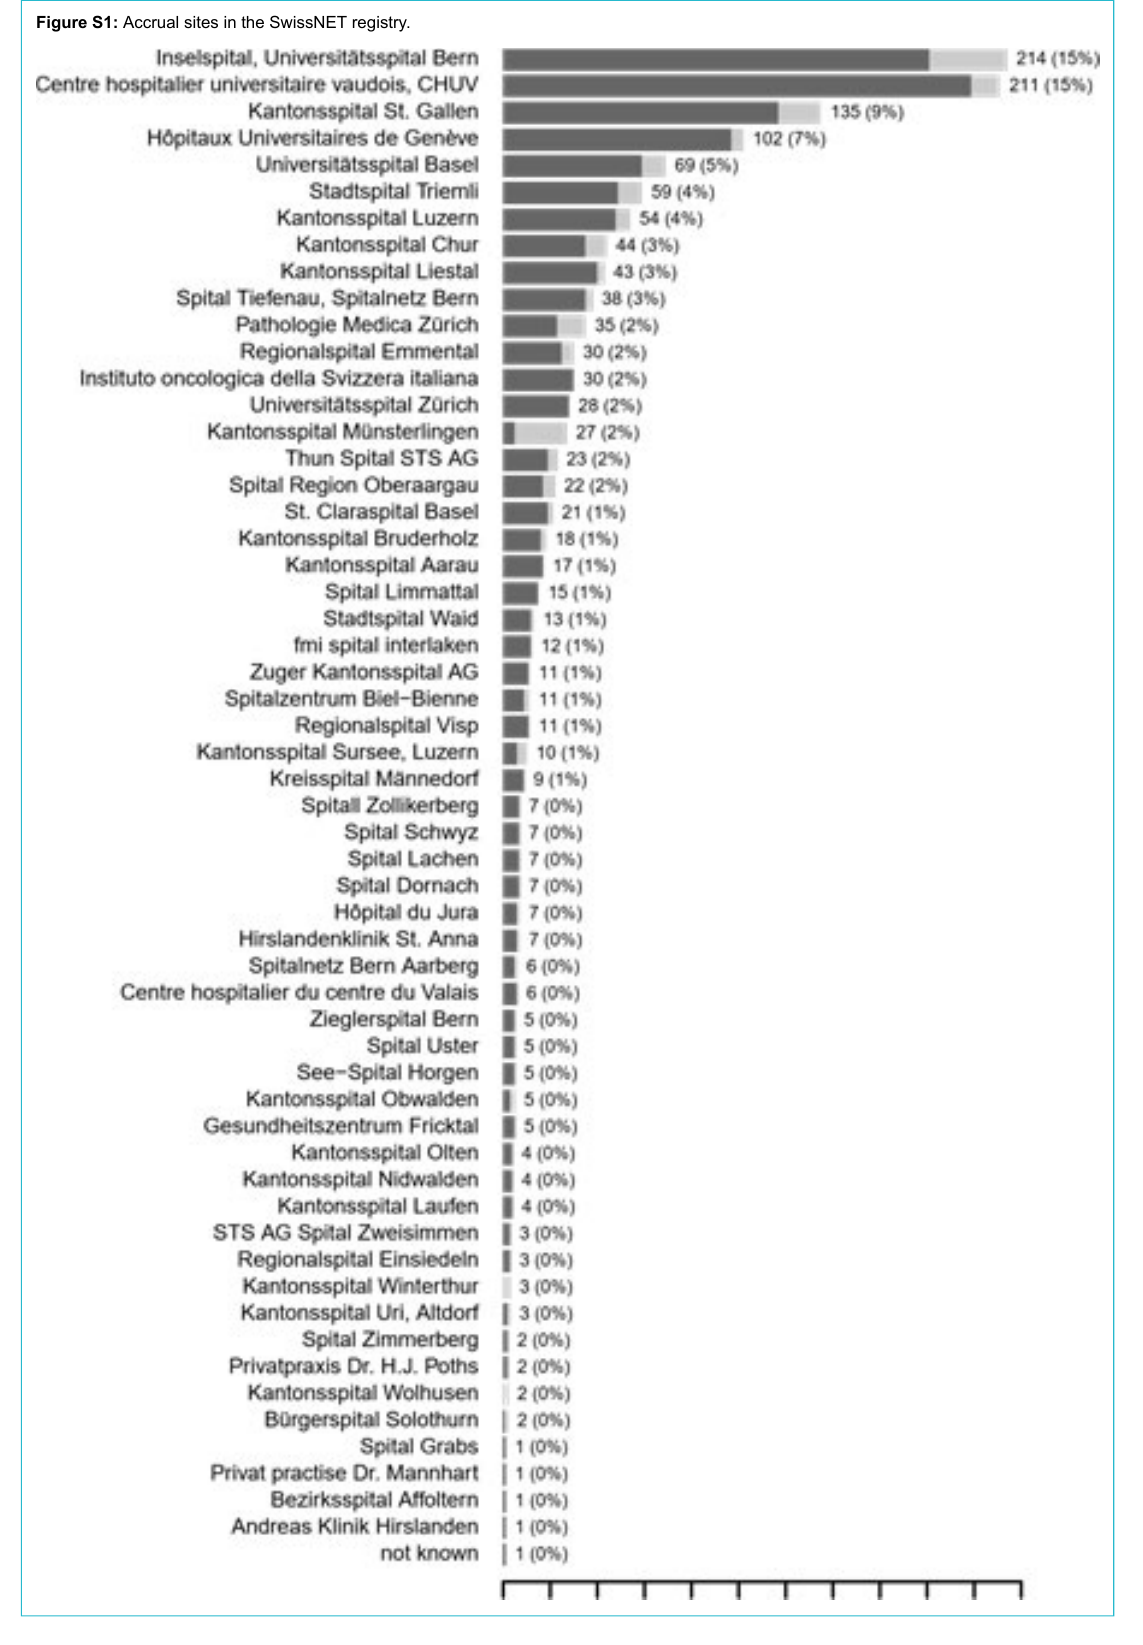
Figure S1: Accrual sites in the SwissNET